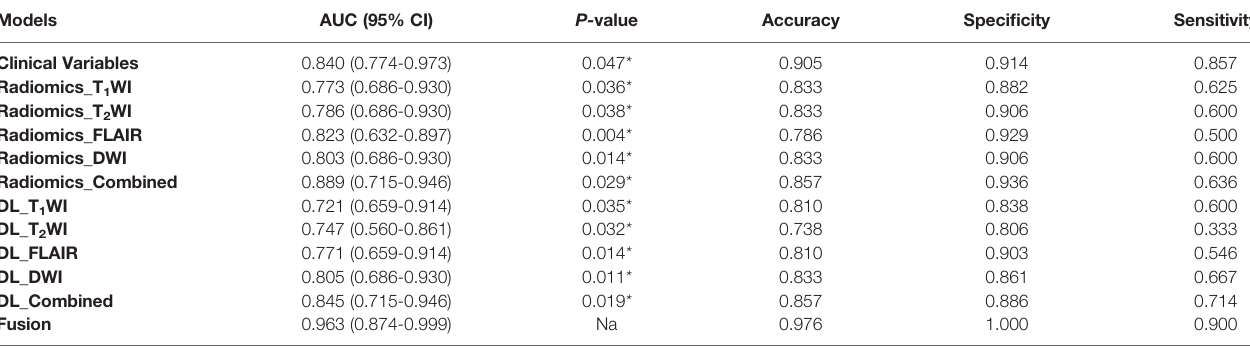
TABLE 3 | Performance measurements generated by clinical model, DL models and radiomics models trained on different sequences in the internal test dataset.